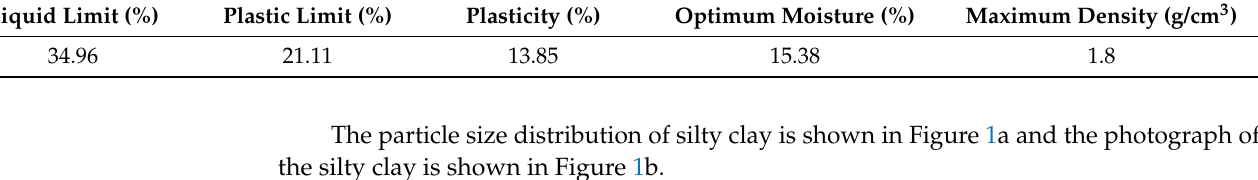
Table 1. Physical properties of test soils.